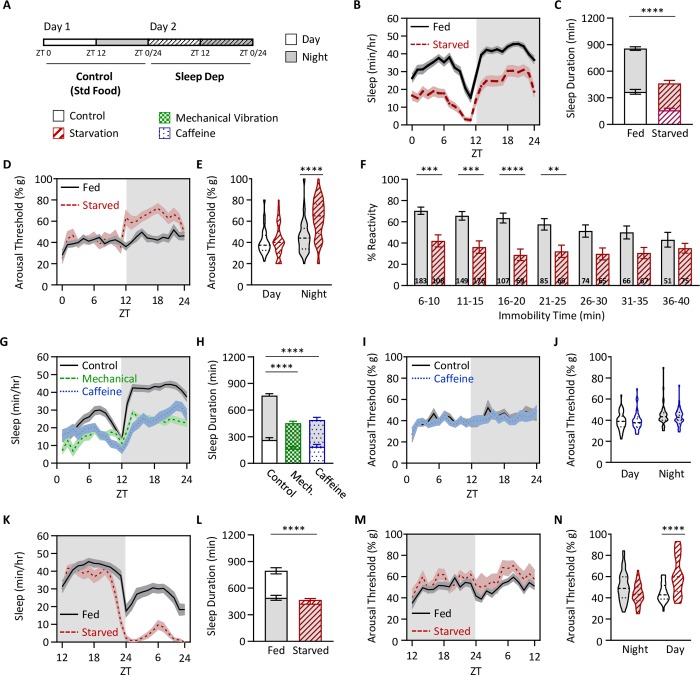
Starvation increases arousal threshold.(A) Total sleep and arousal threshold were assessed for 24 hrs on standard food (Control) and then starved for 24 hrs on agar (Sleep Dep). Flies were flipped to agar at ZT0. (B) Sleep profiles of fed and starved flies. (C) Sleep duration decreases in the starved state (two-way ANOVA: F1,220 = 54.63, P<0.0001), and occurs in both the day (P<0.0001) and night (P<0.0001). (D) Profile of arousal threshold of fed and starved flies. (E) Arousal threshold significantly increases in the starved state (REML: F1,110 = 34.68, P<0.0001), and occurs only at night (day: P = 0.2210; night: P<0.0001). (F) Sleep depth is not correlated with sleep duration in starved flies. The proportion of flies that reacted to a mechanical stimulus for each bin of immobility was assessed. Starved flies are significantly less likely to respond to a mechanical stimulus during sleep (ANOVA: F1,1230 = 68.47, P<0.0001), specifically when flies have been sleeping for less than 30 min (6–10 min: P<0.0001; 11–15 min: P = 0.0002; 16–20 min: P<0.0001; 21–25 min: P = 0.0094; 26–30 min: P = 0.0538). Numbers within each bar represent the frequency of individuals for each bin of immobility. All measurements were taken at night. (G-J) Sleep and arousal threshold measurements were taken over a 24 hr period from flies on standard food media or 1% agar. Flies were flipped to agar at ZT12. (G) Sleep profiles of fed and starved flies. (H) Sleep duration decreases in the starved state (two-way ANOVA: F1,172 = 32.22, P<0.0001), but occurs only during the day (day: P<0.0001; night: P = 0.2036). (I) Profile of arousal threshold of fed and starved flies. (J) Arousal threshold significantly increases in the starved state (REML: F1,74 = 9.248, P<0.0027) and occurs only during the day (day: P<0.0001; night: P = 0.0960). (K-N) Unlike starvation, other methods of sleep deprivation do not increase nighttime arousal threshold. Flies were sleep deprived for 24 hrs using either mechanical vibration or 0.5mg/mL caffeine. (K) Sleep profile. (L) Relative to control, sleep duration significantly decreases for each method of sleep deprivation (two-way ANOVA: F1,234 = 21.58, P<0.0001), and occurs only at night (P<0.0001). (M) Profile of arousal threshold. (N) Arousal threshold remains unchanged when using each of the described methods of sleep deprivation (REML: F1,72 = 0.2563, P = 0.6142, N = 38). Arousal threshold via mechanical vibration was unable to be calculated since the mechanical vibration used to assess arousal threshold was being used to implement sleep deprivation. For profiles, shaded regions indicate +/- standard error from the mean. White background indicates daytime, while gray background indicates nighttime. For sleep measurements, error bars represent +/- standard error from the mean. For arousal threshold measurements, the median (dashed line) as well as 25th and 75th percentiles (dotted lines) are shown. ** = P<0.01; *** = P<0.001; **** = P<0.0001.